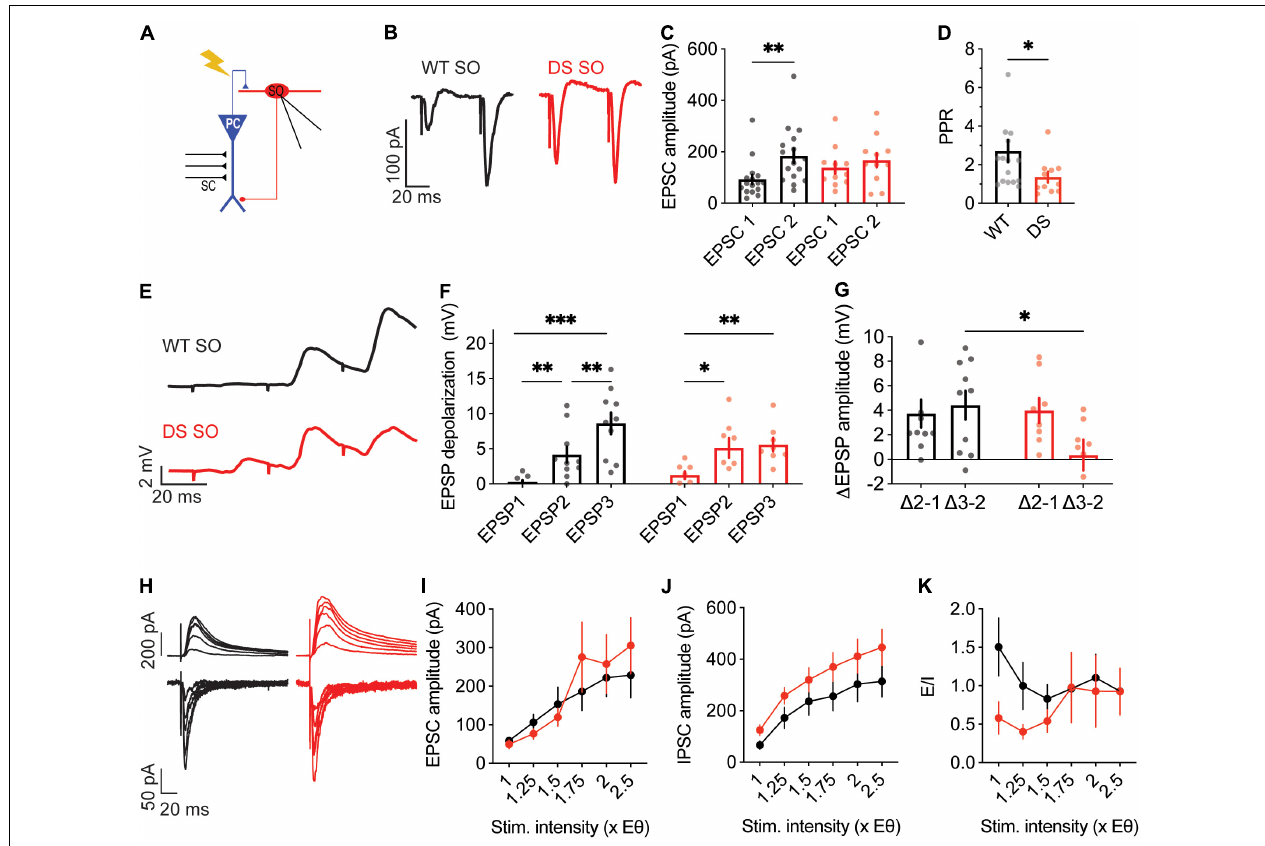
FIGURE 7 | Reduced paired pulse facilitation, with normal excitatory and inhibitory synaptic currents, in DS Scn1a A1783V / WT SO interneurons. (A) Illustration of the experimental setup. Synaptic activation of SO interneurons was triggered by stimulation of the alveus. (B) Representative traces of WT (black) and DS (red) paired-pulse responses. (C) Average EPSC amplitudes of the 1st and 2nd stimuli that were given within 50 ms. Statistical analysis utilized Two Way Repeated Measures ANOVA. The markings depict the results of Bonferroni post hoc analysis: p = 0.62 for genotype, p = 0.01 ( ∗ ) for the EPSC number, p = 0.16 for the interaction. (D) Paired-pulse ratio (EPSP2/EPSP1). Statistical analysis utilized the Mann–Whitney test. WT: n = 17 cells from 5 mice; DS: n = 11 cells from 4 mice. (E) Representative EPSPs in WT and DS SO interneurons in response to a train of stimuli at 30 Hz. (F) EPSP amplitude at each of the three stimuli. Statistical analysis utilized Two Way Repeated Measures ANOVA. The markings depict the results of Bonferroni post hoc analysis: p = 0.75 for genotype; p < 0.001 ( ∗∗∗ ) for the EPSP number, p = 0.052 for the interaction. (G) The added depolarization of each EPSPs. Statistical analysis utilized Two Way Repeated Measures ANOVA. The markings depict the results of Bonferroni post hoc analysis: p = 0.07 for genotype; p = 0.28 for the EPSP added depolarization; p = 0.12 for the interaction. WT: n = 10 cells from 6 mice; DS: n = 9 cell from 5 mice. (H–J) Representative traces (H) and average EPSCs (I) and IPSCs (J) evoked by alveus stimulation at different stimulation intensities from WT and DS mice. EPSCs were measured at a holding potential –60 mV, and IPSCs were measured at 0 mV. Statistical analysis utilized Two Way Repeated Measures ANOVA. For the EPSCs: p = 0.7 for genotype; p = 0.4 for the interaction; for the IPSCs: p = 0.15 for genotype; p = 0.68 for the interaction. (K) E/I ratio. Statistical analysis utilized Mixed Model Repeated Measures ANOVA: p = 0.1 for genotype; p = 0.3 for the stimulation intensity; p = 0.51 for the interaction. WT: n = 12 cells from 3 mice; DS: n = 11 cells from 3